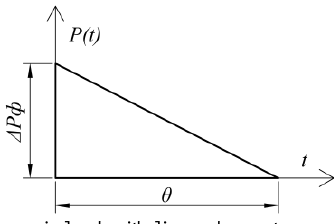
Fig. 4. Immediate increase of dynamic load with linear descent When calculating the linearized law of pressure variation in time was applied which is defined by the dependence